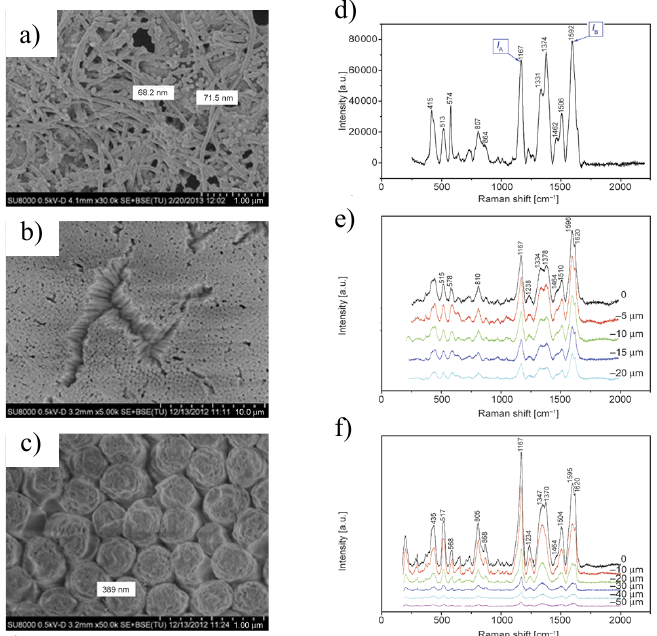
Figure 4. ( a ) Different magnifications of PANI into 45 nm AAO pores ( a ) and 300 nm AAO pore ( b ) and ( c ); ( b ) Raman spectrum of PANI bulk ( d ), PANI polymerized in AAO templates of 300 nm ( e ) and idem in 45 nm ( f ) [116]. Copyright 2016. Reproduced with permission from the publisher: Budapest University of Technology and Economics.